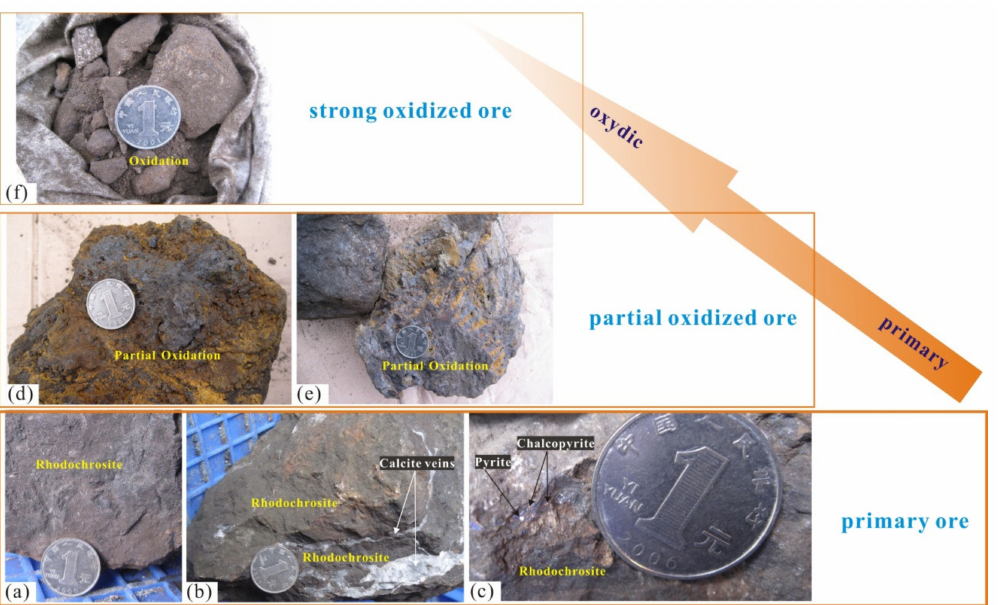
Figure 4. Specimens of Mn–Ag ore from the Sanbao deposit: ( a ) rhodochrosite is the main mineral composition of pre-ore (primary ore); ( b ) typical vein structure in rhodochrosite; ( c ) pyritization with chalcopyrite in rhodochrosite; ( d ) partial oxidized syn-ore mainly is composed of diopside and has a porous texture; ( e ) there are many pores (voids), even cracks, and loose texture in partial oxidized syn-ore; ( f ) unconsolidated and powdery texture in the post-ore (strong oxidized-ore).